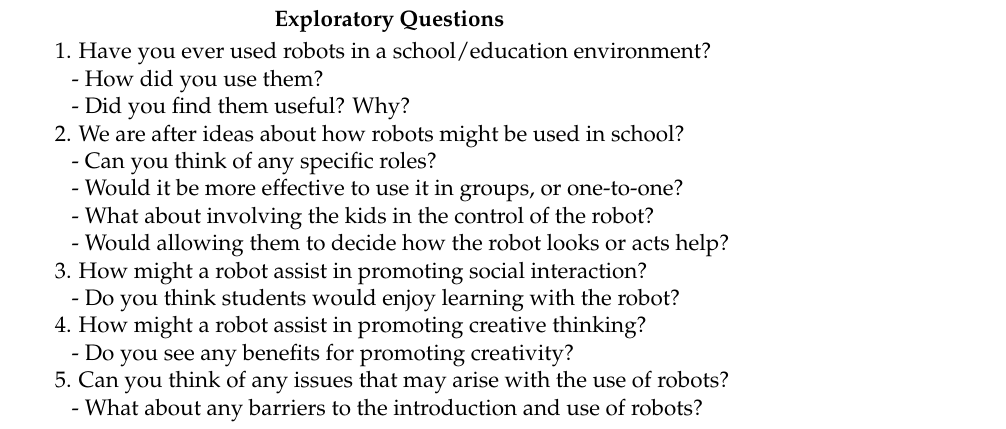
Table 2. Subset of exploratory focus group questions.